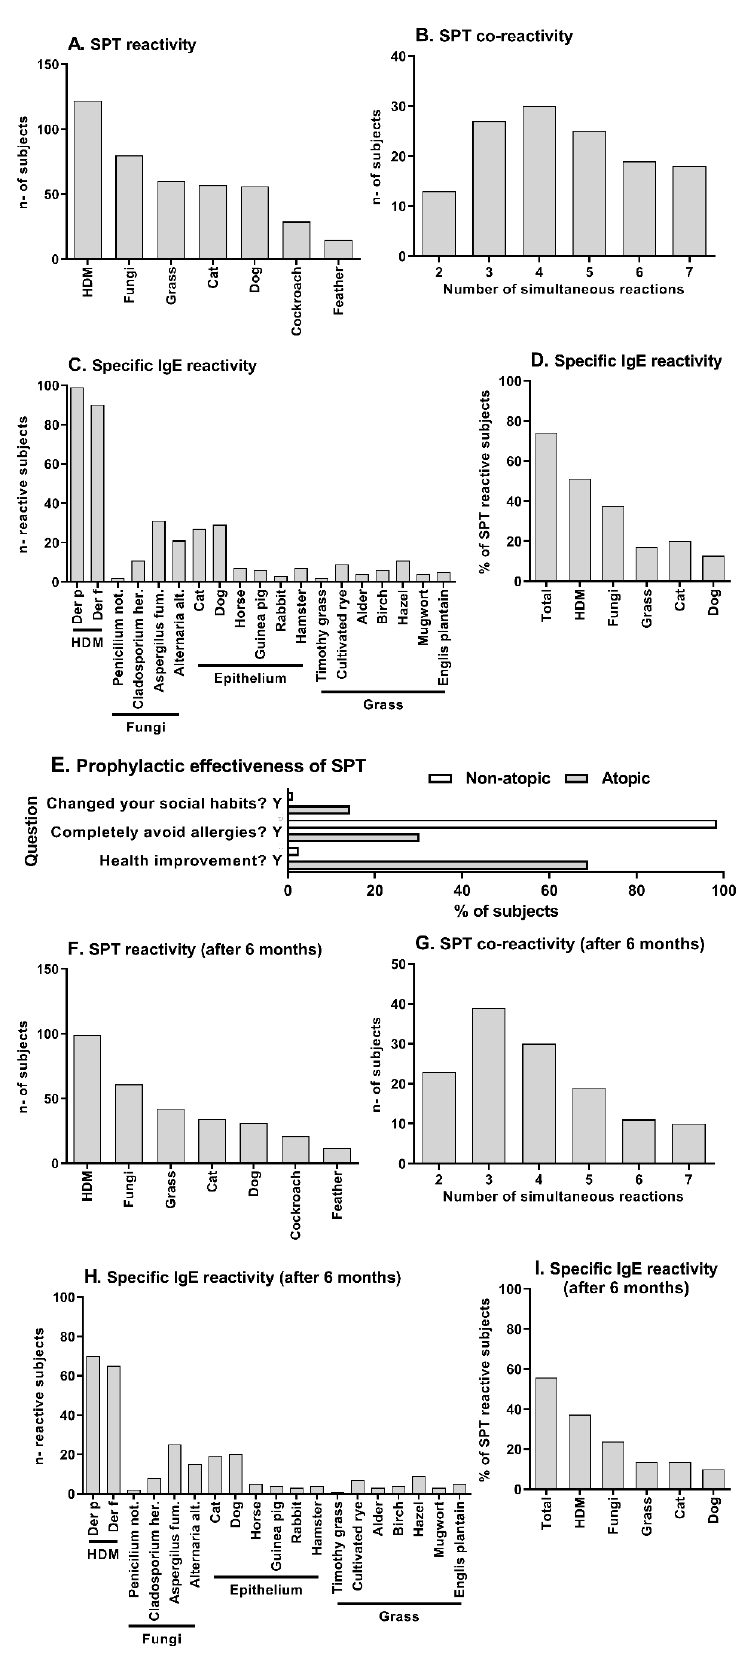
Figure 1. SPT reactivity, serum specific-IgE titers, and individual orientation effectiveness. Atopic (n: 132) or non-atopic (n: 102) volunteers with high indoor permanence were submitted to SPT, and